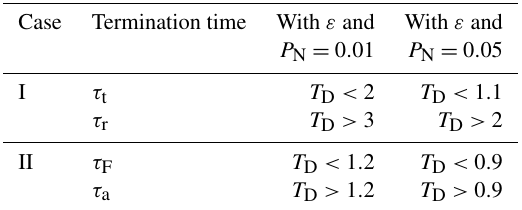
Table 2. Criteria utilized to calculate the termination of bilinear flow. See discussion for the definition of the cases I and